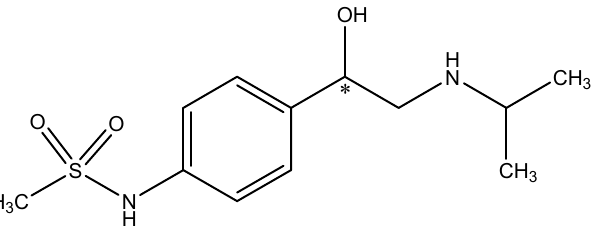
Figure 2. Structure of racemic mixture of sotalol. Reprinted with permission from [28]; copyright Indian Pharmaceutical Association 2018.